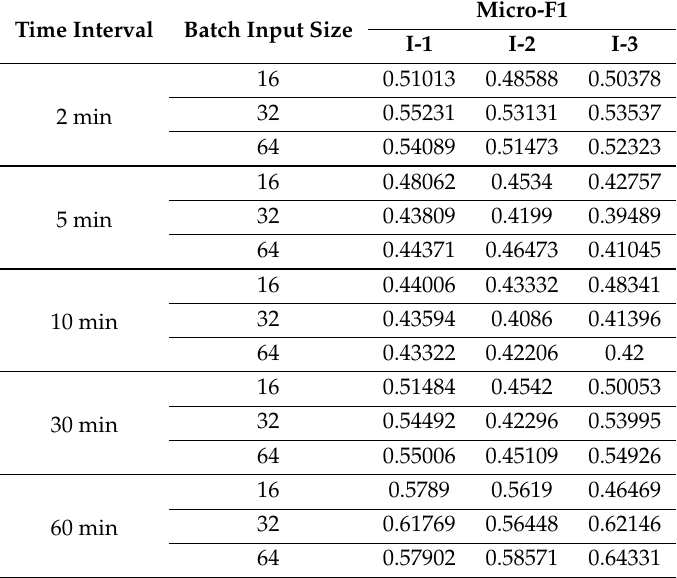
Table 7. Mean micro averaged F1 testing results of all events that are obtained using leave-one-event-out cross-validation along T by varying batch input size.